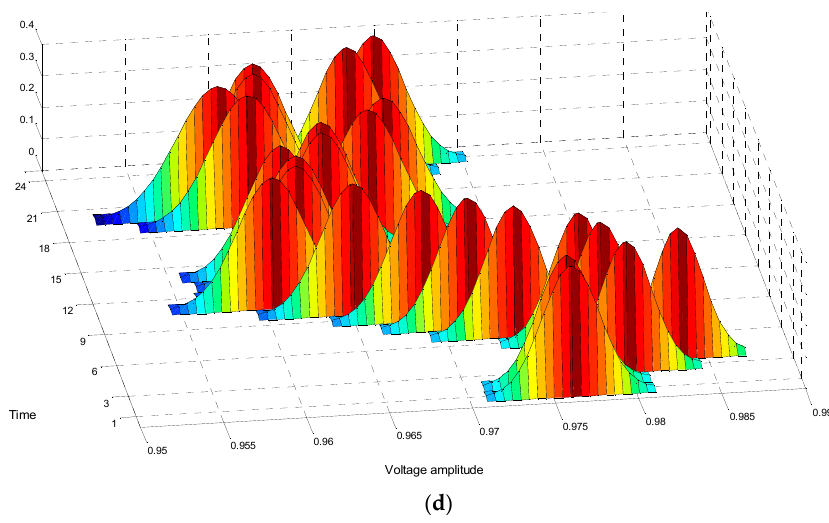
Figure 9. The voltage probabilistic distribution of the bus 17 under different cases. ( a ) Case 1; ( b ) Case 2; ( c ) Case 3; ( d ) Case 4.